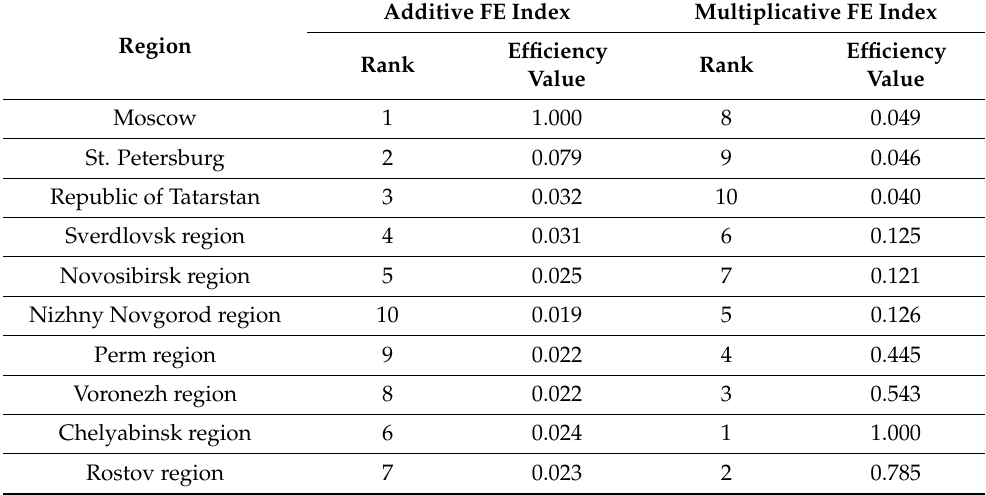
Table 7. Identification of efficient Russian regions, comparing values of the FE index with productive entrepreneurship. Additive FE Region